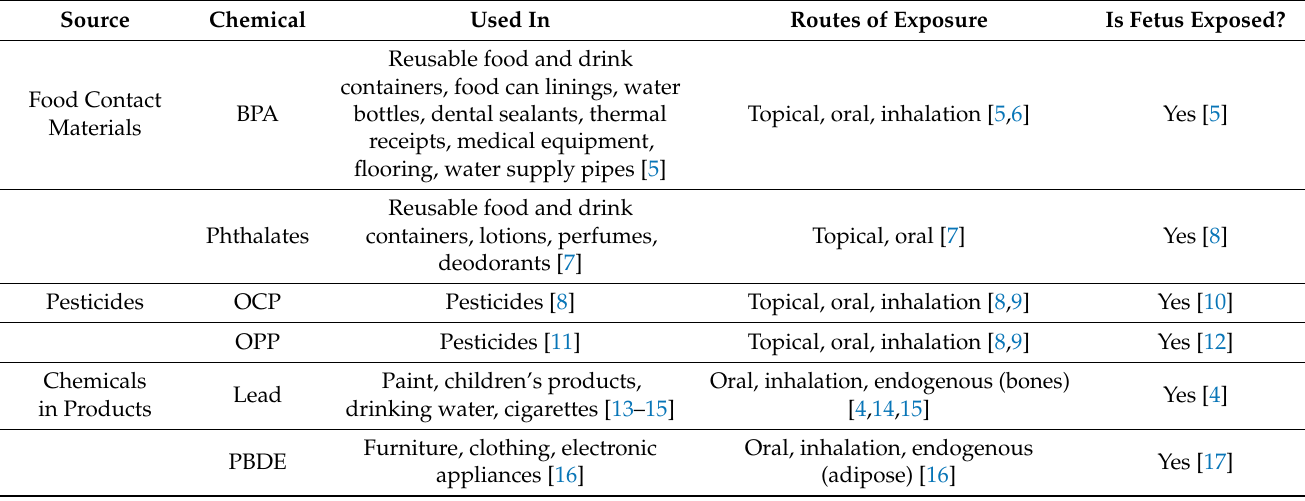
Table 1. Routes of EDC exposure and ability to reach